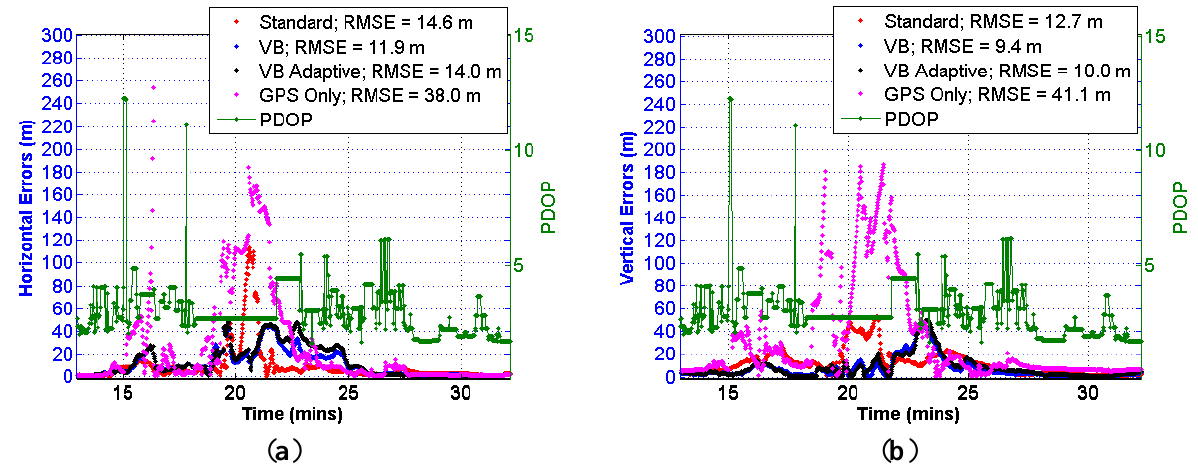
Figure 10. ( a ) Horizontal errors (OEM6 + IMU)—urban canyon. ( b ) Vertical errors (OEM6 + IMU)—urban